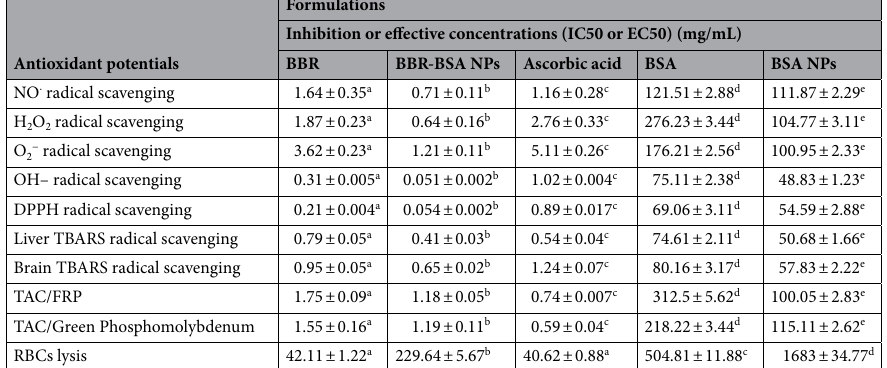
Table 1. The inhibition or the effective concentrations (IC 50 or EC 50 ) of free radicals scavenging activities, total antioxidant capacities, and anti-hemolytic properties of the tested compounds. NO · , nitric oxide; H 2 O 2 , hydrogen peroxide; O 2− , superoxide anion; OH − , hydroxyl radical; DPPH, 1, 1-diphenyl-2-picrylhydrazyl; TBARS, thiobarbituric acid reactive substances; TAC, Total antioxidant capacities; FRP, ferric reducing power; RBCs, red blood cells. Data values are expressed as means ± SD (n = 5). Different letters in the same row indicated statistically significant differences ( P < 0.05) that evaluated using the analysis of one-way ANOVA with post hoc LSD test. The same letters in the same row indicated non-significant differences ( p > 0.05).